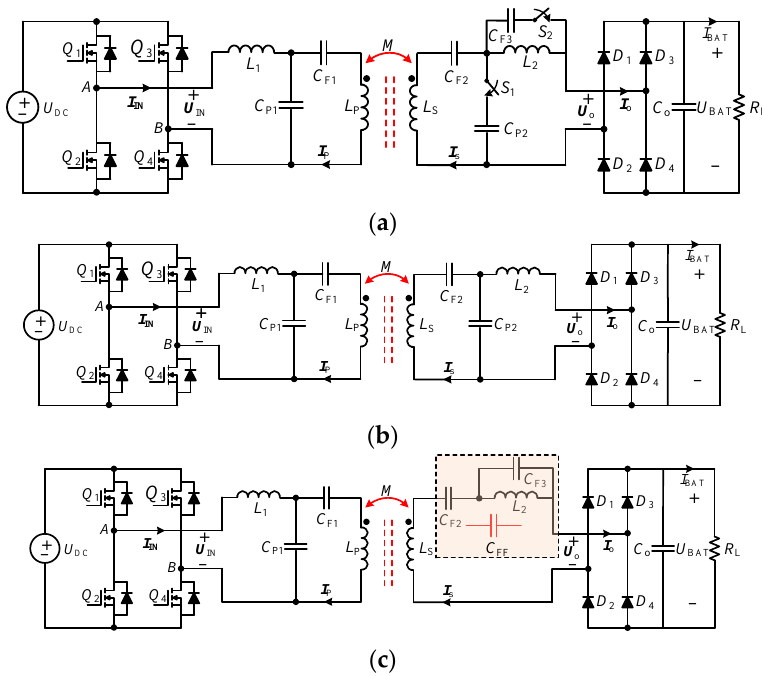
Figure 10. ( a ) Proposed hybrid compensation topology of the WPT systems; ( b ) DS-LCC topology for the CC output; ( c ) LCC-S topology for the CV output.